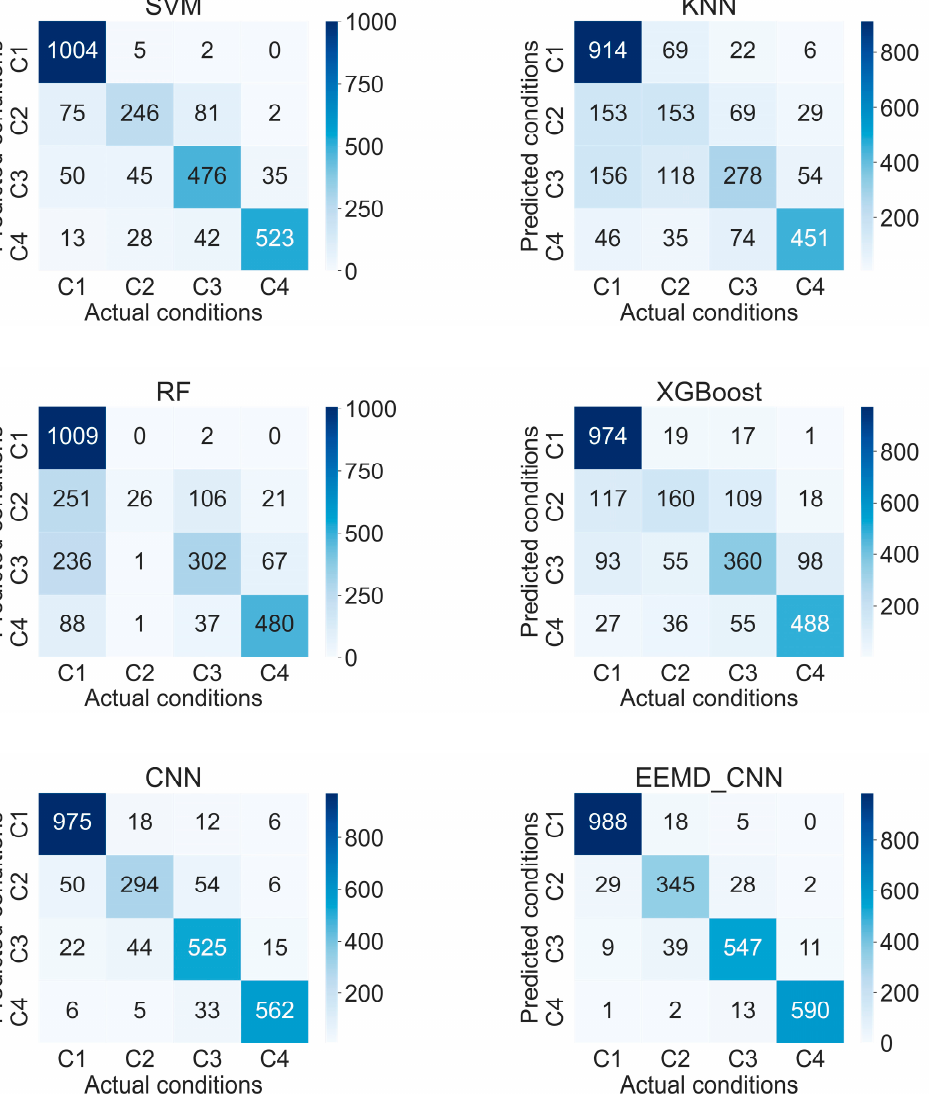
Figure 10. Confusion matrices of different methods.